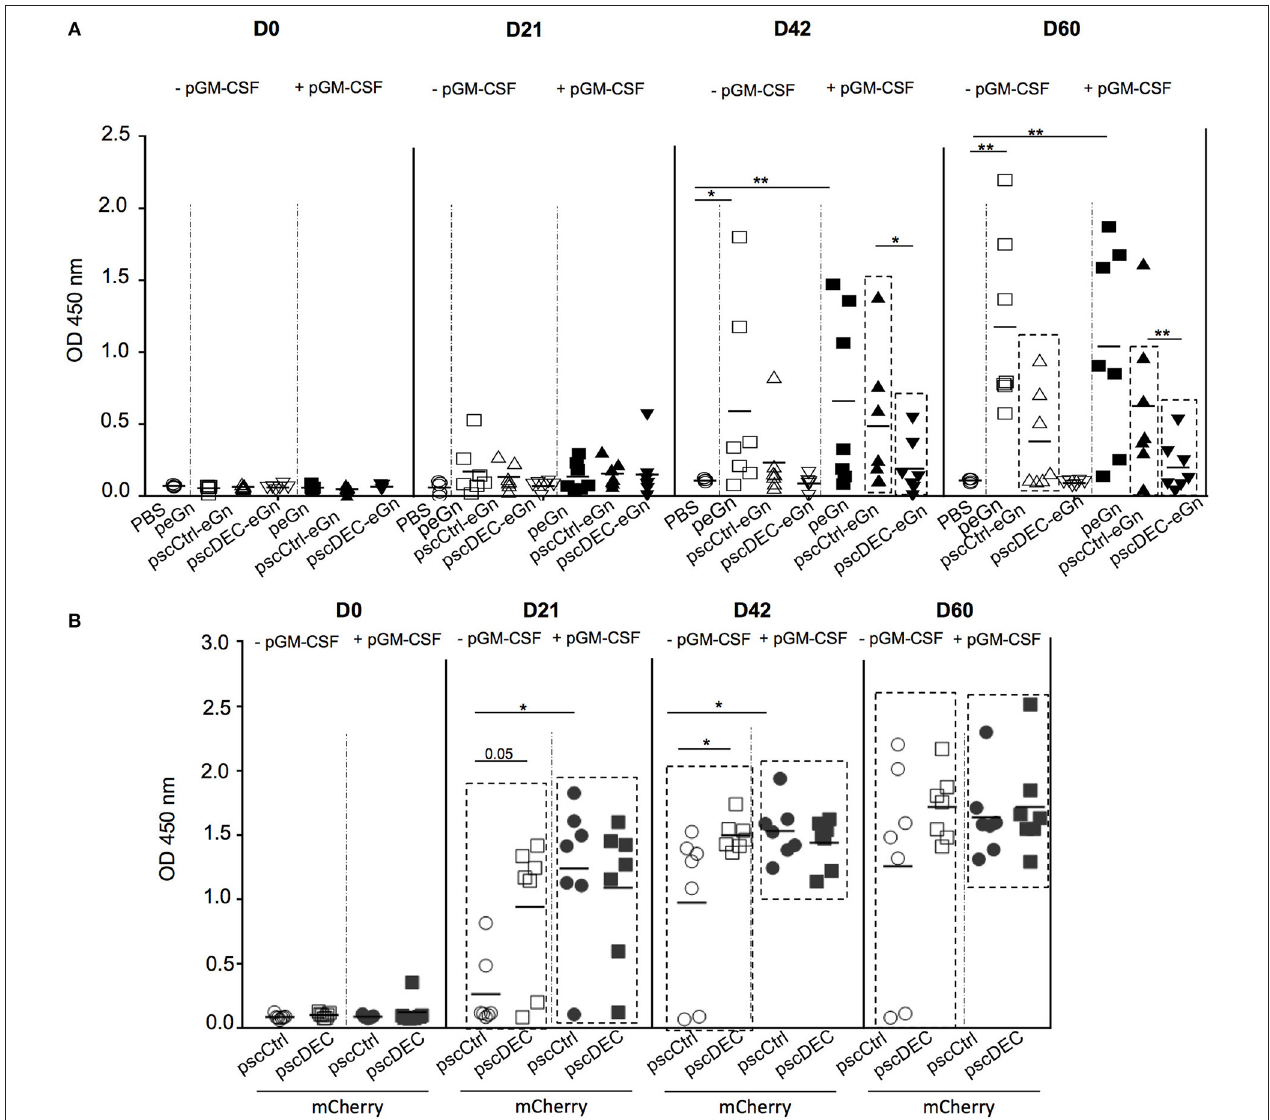
FIGURE 3 | Ab responses induced by eGn and mCherry encoding plasmids. (A) Sera from pscDEC205-eGn, pscCtlr-eGn, and peGn ( ± pGM-CSF) immunized Balb/c (7 per group) were collected at day 0, 21, 42, 60, and were assayed for the detection of eGn-specific IgG using lysate from HEK293 cells transfected with peGn as coating. The OD signals at 450nm from the individual sera collected at each time point and tested at a 1:100 dilution are shown. Each animal is represented with a distinct symbol and the mean OD value is indicated. P- values were determined using to the Mann-Whitney test (* p < 0.05; ** p < 0.01). The significant difference between the OD values measured at each time point in the vaccinated vs. the PBS group is indicated by a box for clarity ( p < 0.05). This experiment has been repeated twice with similar results. (B) Sera from pscDEC205-mCherry, pscCtlr-mCherry ( ± pGM-CSF) immunized Balb/c (7 per group) were collected at day 0, 21, 42, 60, and mCherry-specific IgG were evaluated in 1:100 diluted sera using recombinant mCherry as a coating antigen. Each animal is represented with a distinct symbol and the mean is indicated ( n = 6–7 per group). The experiment has been repeated twice with similar results. P -values were determined using to the Mann–Whitney test (* p < 0.05; ** p < 0.01). The significant differences between the OD values measured at day 0 in comparison to days 21, 42, and 60 are indicated by a box for clarity and were calculated using a non-parametric paired Wilcoxon test ( p <